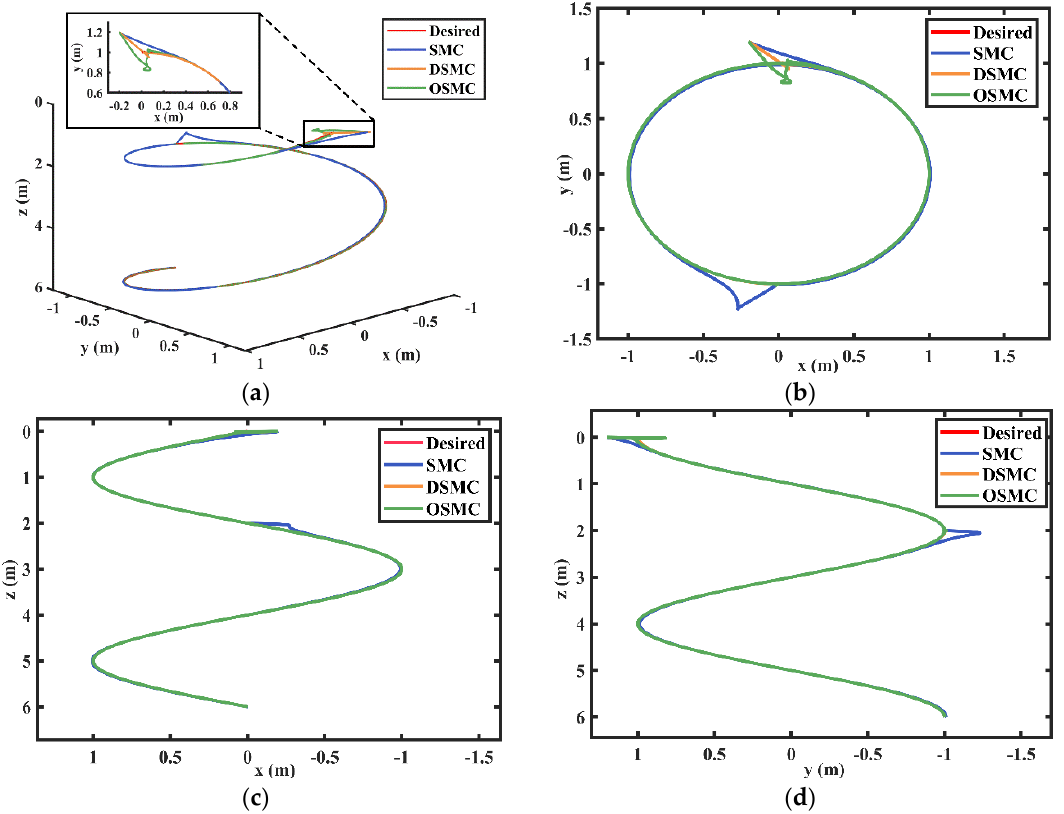
Figure 4. The 3D trajectory tracking results of the ROV under the three control schemes: ( a ) XYZ 3D trajectory; ( b ) XY plane trajectory; ( c ) XZ plane trajectory; ( d ) YZ plane trajectory.